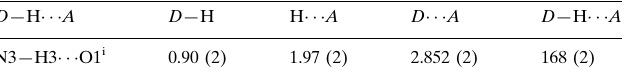
Hydrogen-bond geometry (A˚ , (cid:2)